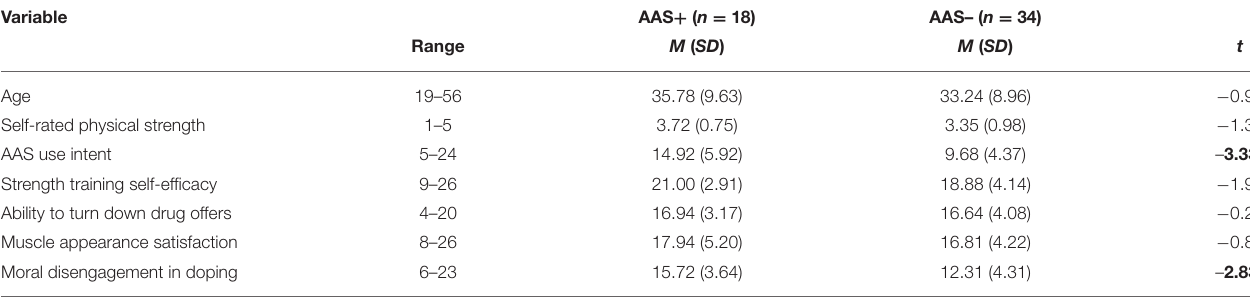
TABLE 5 | Baseline comparison of baseline-posttest “lifetime” AAS-users (AAS + ) and non-users (AAS–). Variable